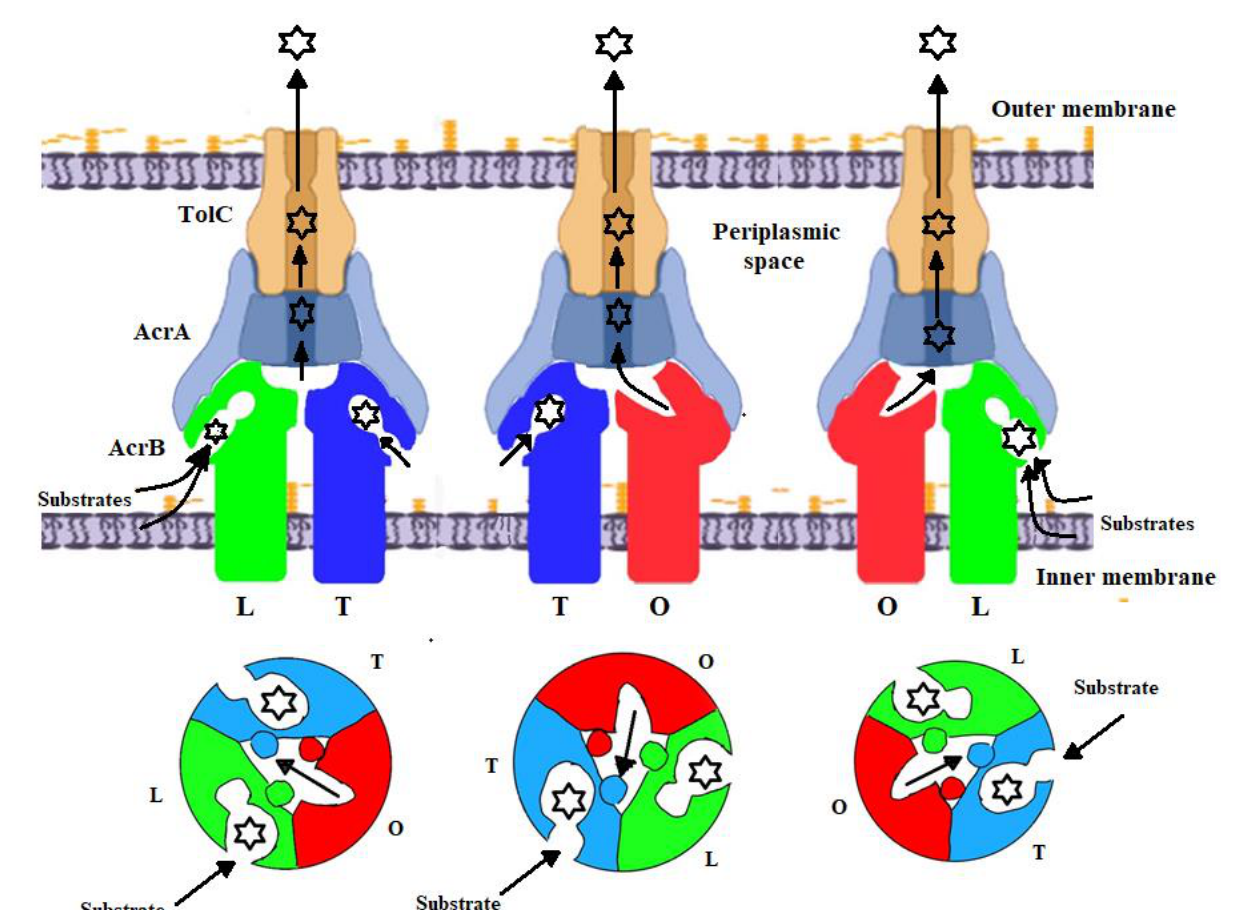
Figure 4. Schematic diagram showing the functional rotational mechanism of the tripartite complex AcrAB-TolC drug efflux pump. The upper and lower panels show the side and horizontal views of the complex, respectively. The three conformations of AcrB, defined as the loose (L: green), tight (T: blue) and open (O: red) are depicted that serve as the substrate access, binding and extrusion states, respectively. AcrA (light blue) and TolC (pale orange) are also shown. Substrates are indicated by black jagged circles. The movement of protons through AcrB is also shown.